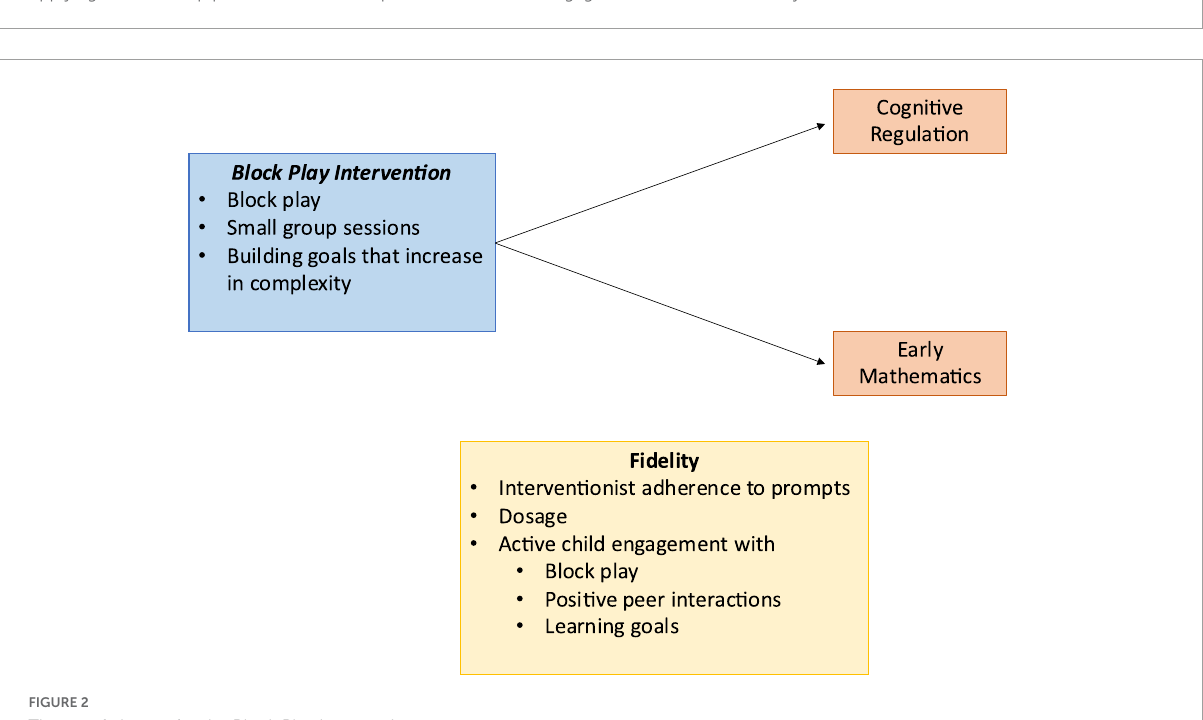
FIGURE1 Applying the four-step protocol to measure preschoolers’ active engagement with the Block Play Intervention.